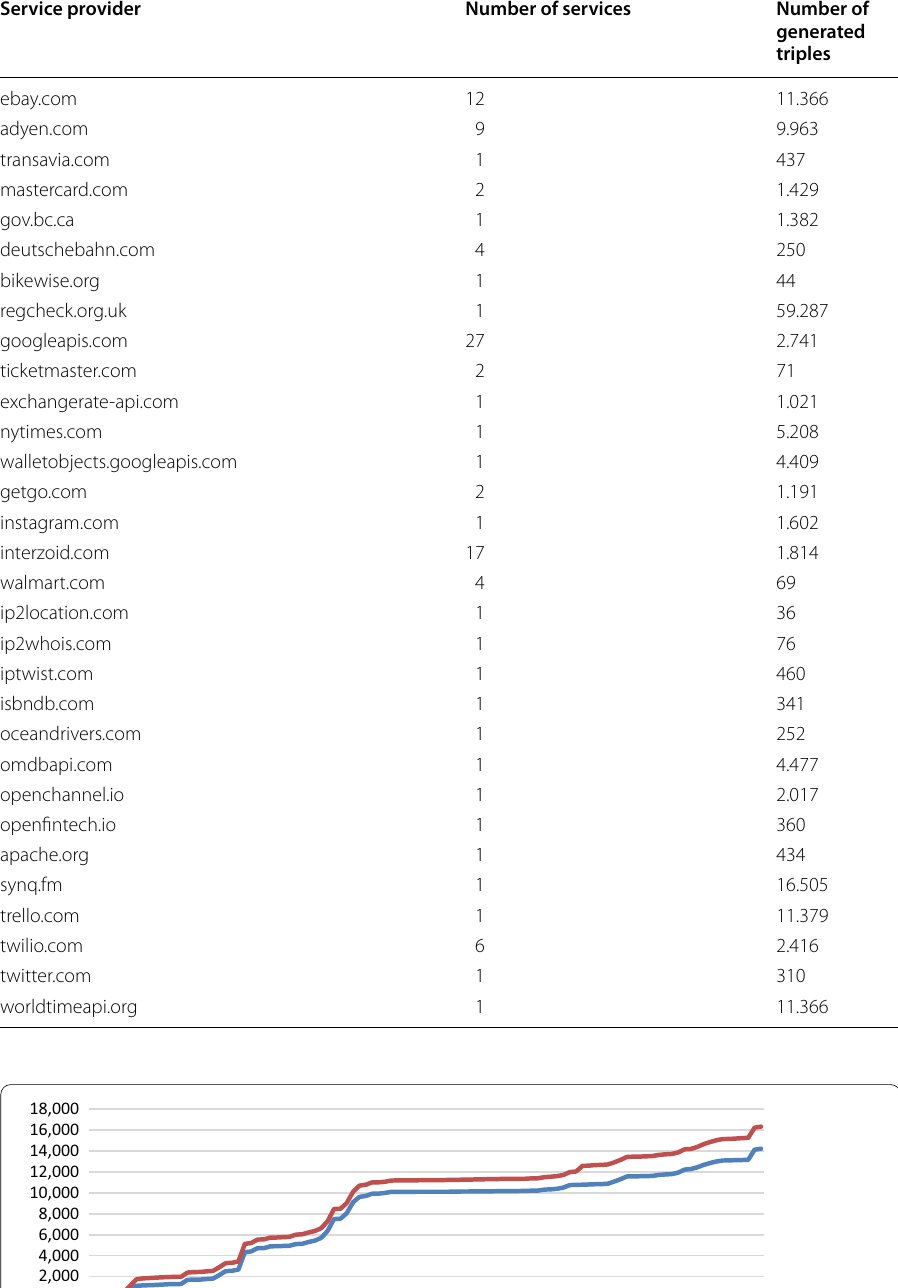
Table 8 OAS document distribution per service provider and number of generated triple